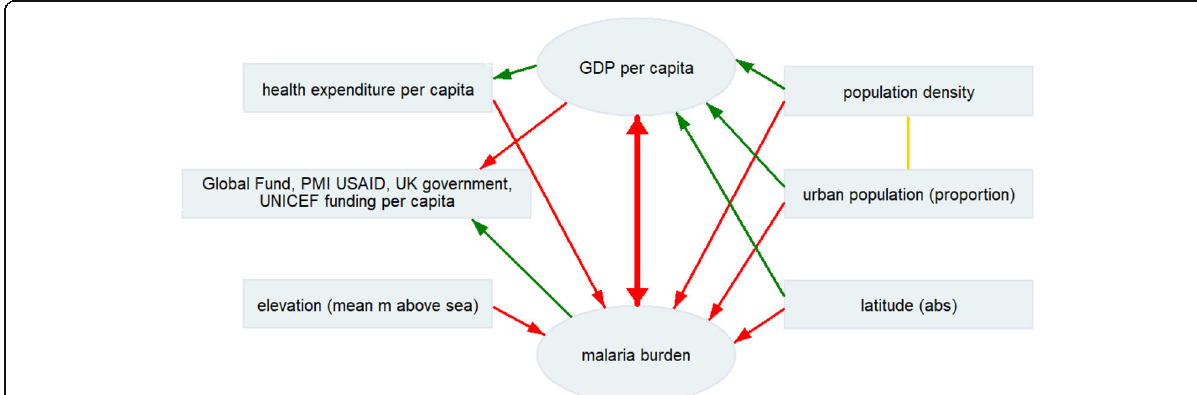
Fig. 2 Relationships of malaria burden and social, economic and environmental parameters. * green line indicates a positive correlation, red line indicates a negative correlation, yellow line indicates an interaction between parameters. GDP: gross domestic product; HDI: human development index; PMI: United States President ’ s Malaria Initiative; UK: United Kingdom of Great Britain and Northern Ireland; UNICEF: United